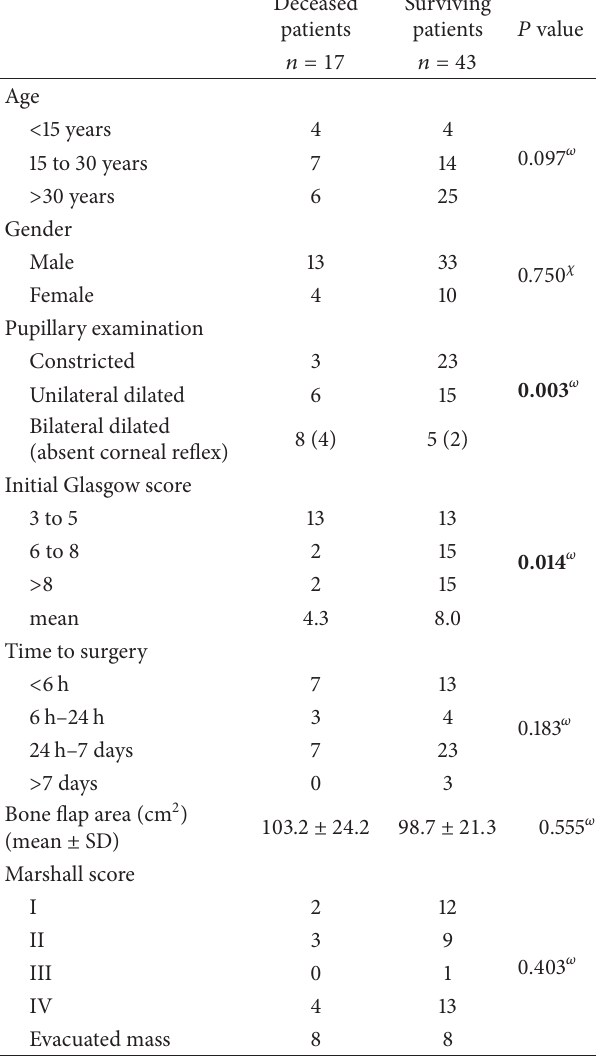
Table 3: Analysis of prognostic factors for